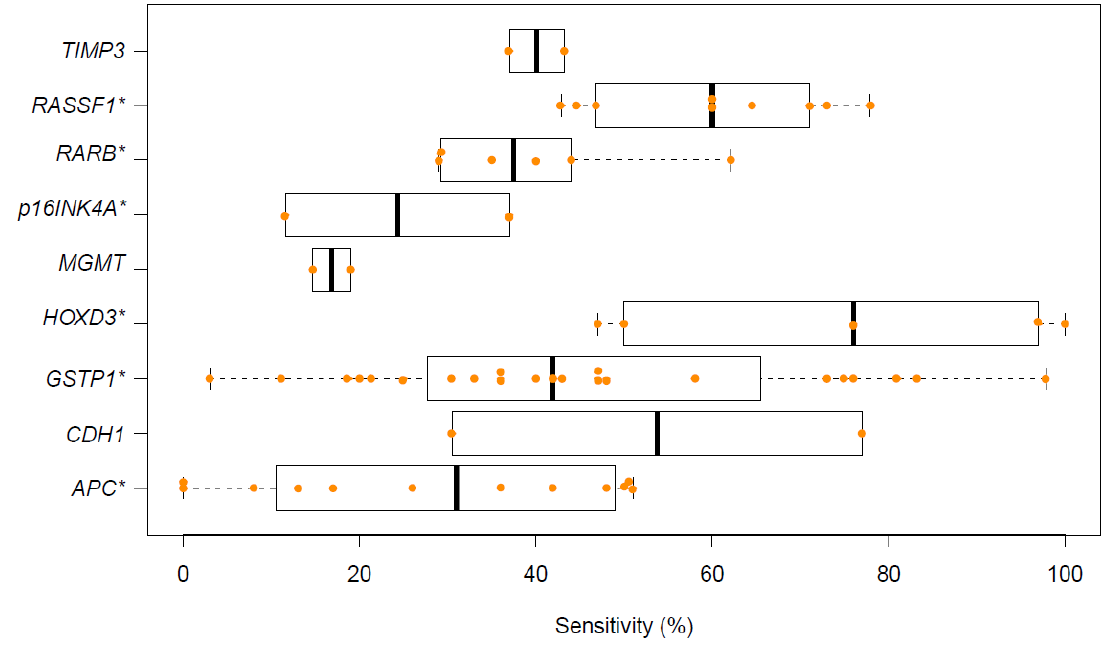
Figure 2. Reported sensitivities of DNA methylation biomarkers for detection of prostate cancer. *, *, Inconsistent nomenclature among Inconsistent nomenclature among studies.